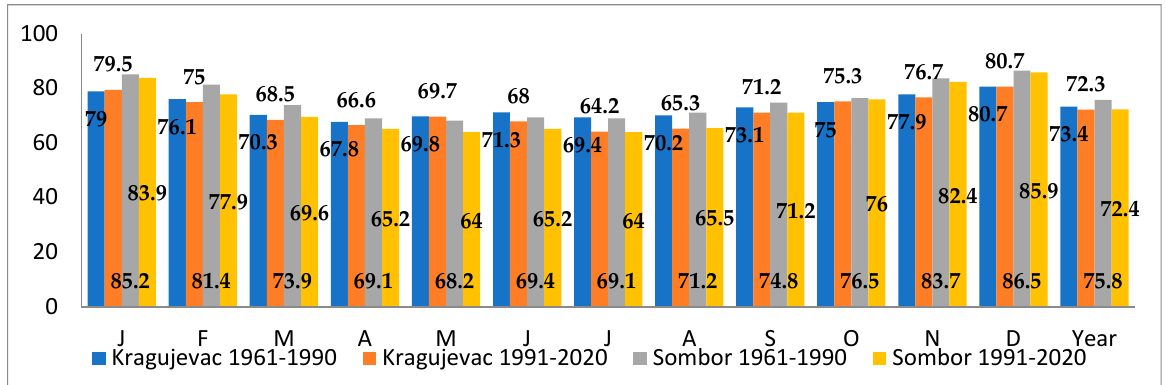
Figure 6. Amount of precipitation in average per month from growth stage to ripening of maize (April-September) in Kragujevac and Sombor for the periods 1961–1990 and 1991–2020. Source: RHMS-Meteorological yearbooks.